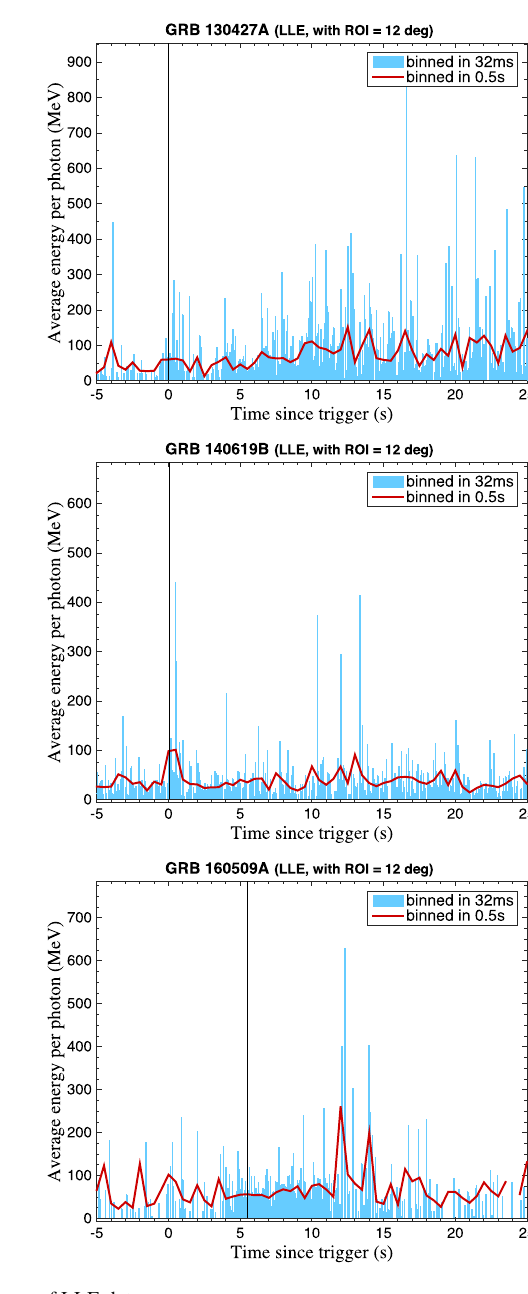
ficult to choose characteristic times from the LLE average energy curves to match the peaks in the light curves. One possible reason is that, for LLE data, the energy distribution of GRB photons is similar to that of background photons. For example, we plot the energy distribution histogram from the LLE data of GRB 160509A, using the events: (1) within 4– 10 s (in the source frame) since trigger and (2) before trigger (see Fig. 15). From the light curve, Case 1 covers an inten- sive GRB process and Case 2 covers the background